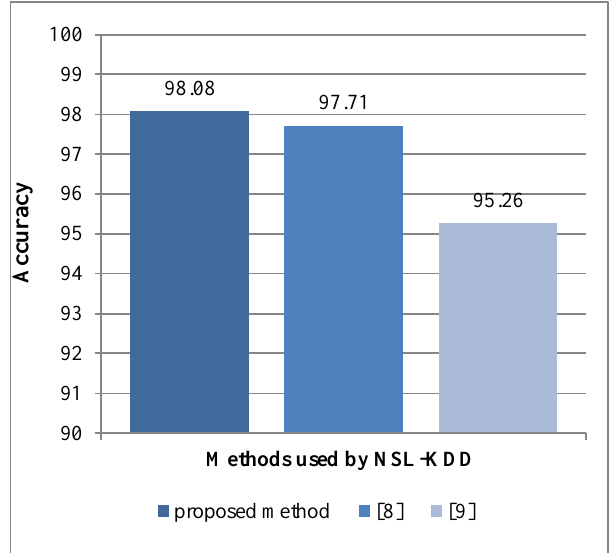
Figure 8. Comparing the function of the proposed model with the other models for the NSL